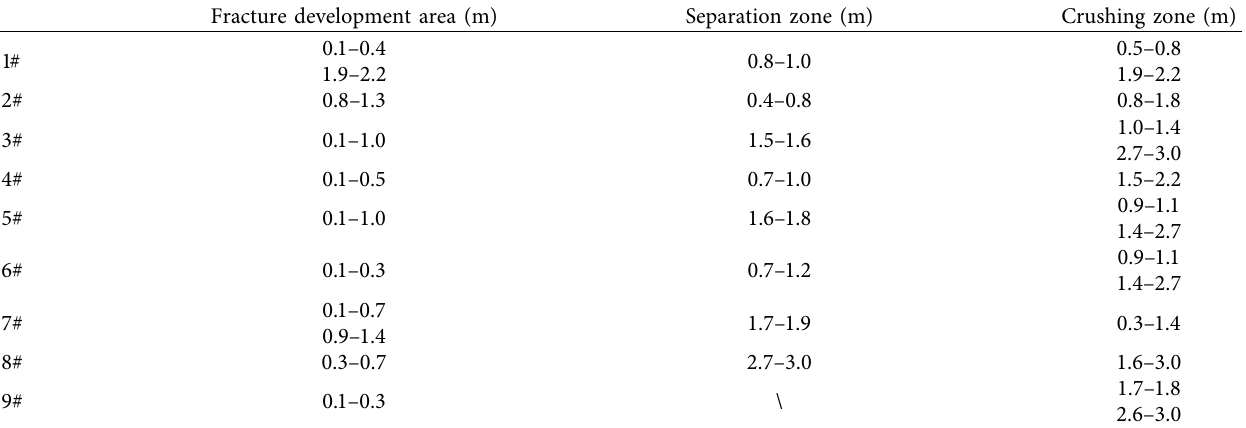
Table 3: Data of borehole peeping